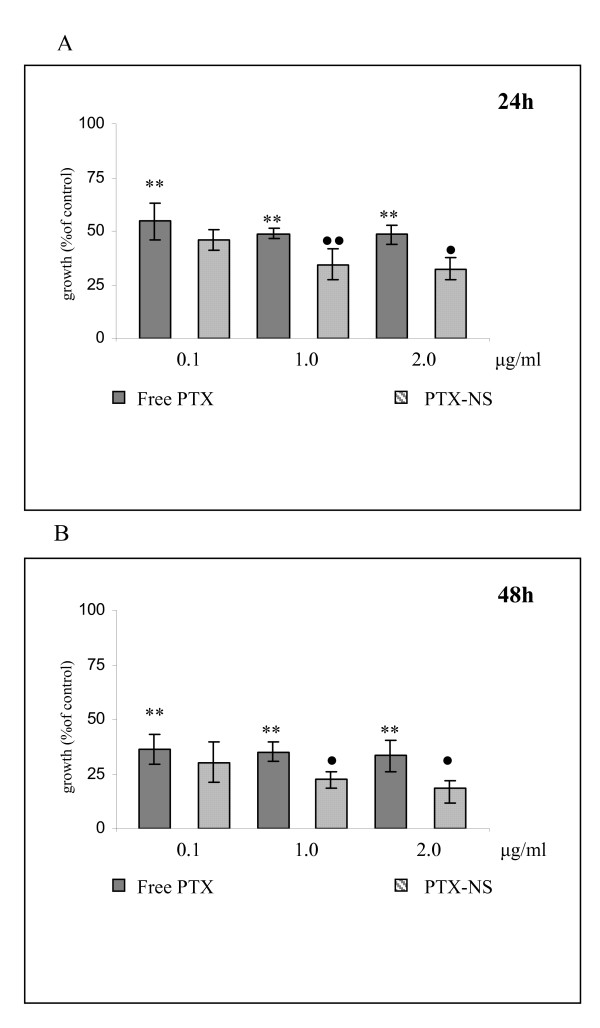
Cytotoxicity of free PTX and PTX-NS in RT 112 cells. RT 112 cells were treated with increasing concentrations (0.1 – 2.0μg/ml) of either free PTX or PTX-NS for 24 (7A) or 48 (7B) h and cell viability was assessed by the MTS assay. Data are expressed as % of viable cells (mean ± SD of three separate experiments, each performed in triplicate) exposed to PTX in respect to untreated controls. • free PTX vs. PTX-NS, *treated vs. not treated •*p < 0.05 ••**p < 0.01